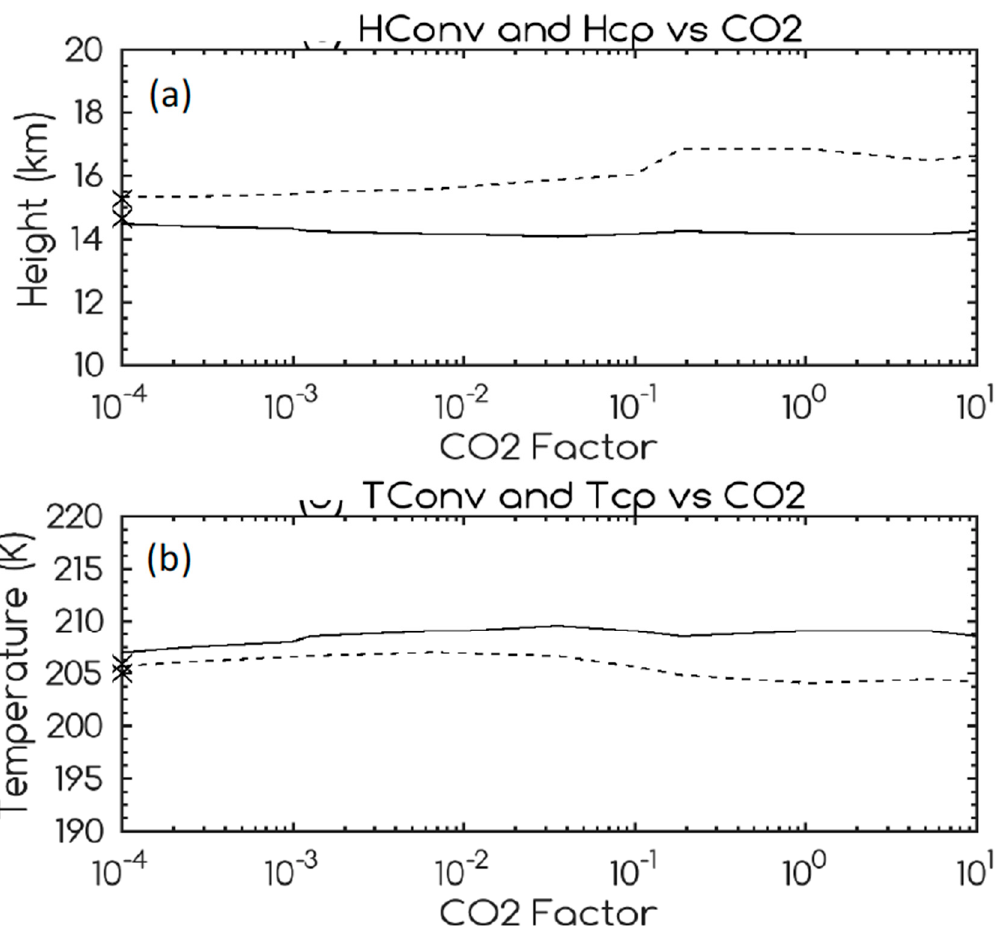
Figure 4. ( a ) Dependence of the convection-top height (solid) and the cold-point height (dashed) on the carbon dioxide scaling factor. ( b ) Dependence of the convection-top temperature (solid) and the cold-point temperature (dashed) on the carbon dioxide scaling factor. The “X” symbols represent the states for f = 0 (i.e., zero CO 2 mixing ratio).